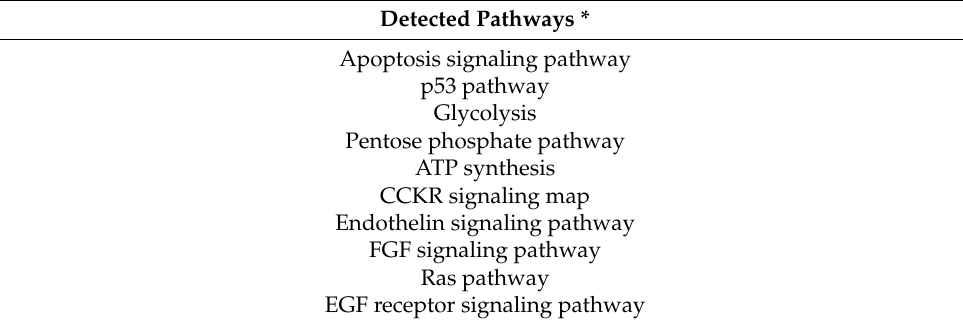
Table 2. Protein and energy metabolism-related pathways stimulated by supplementation of L-Trp compared with